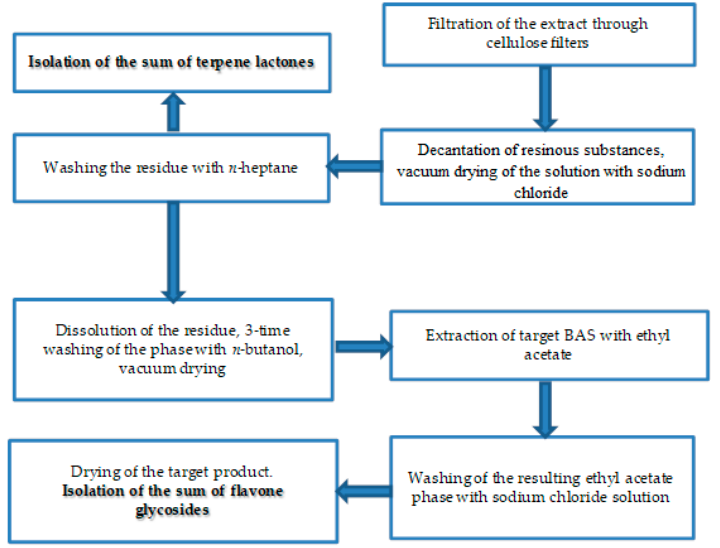
Figure 6. Scheme of isolation of biologically active substances from the extract of Ginkgo biloba .